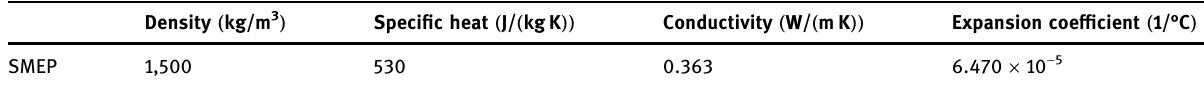
Table 3: Thermophysical parameters of SMEP